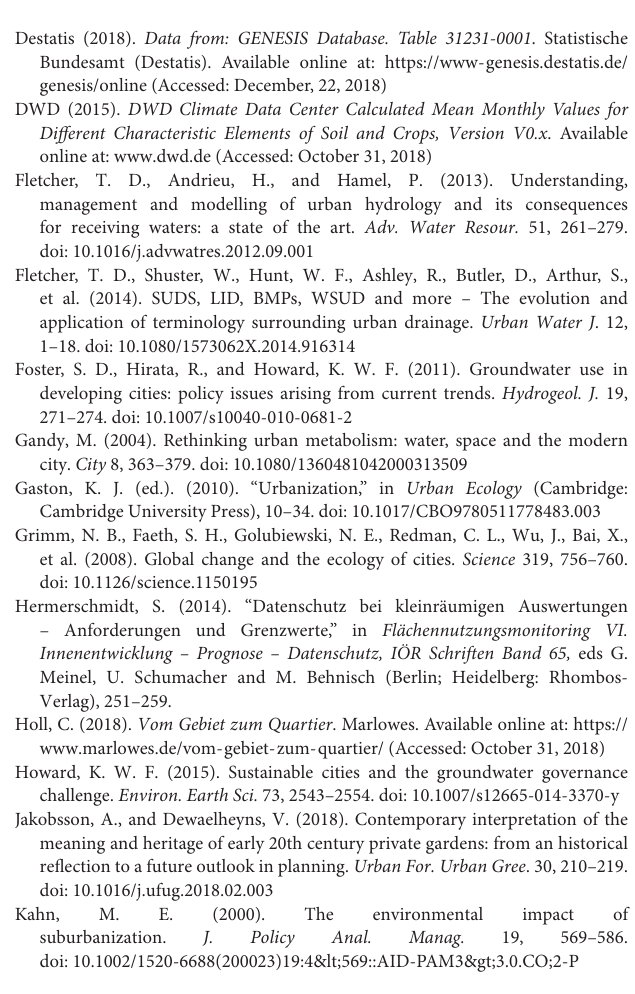
Supplementary Figure 1 | Euler Type II design rains of 1-h duration and annuality between 0.5 and 100 years in 5-min resolution, including the total amount of precipitation in mm over the whole interval of